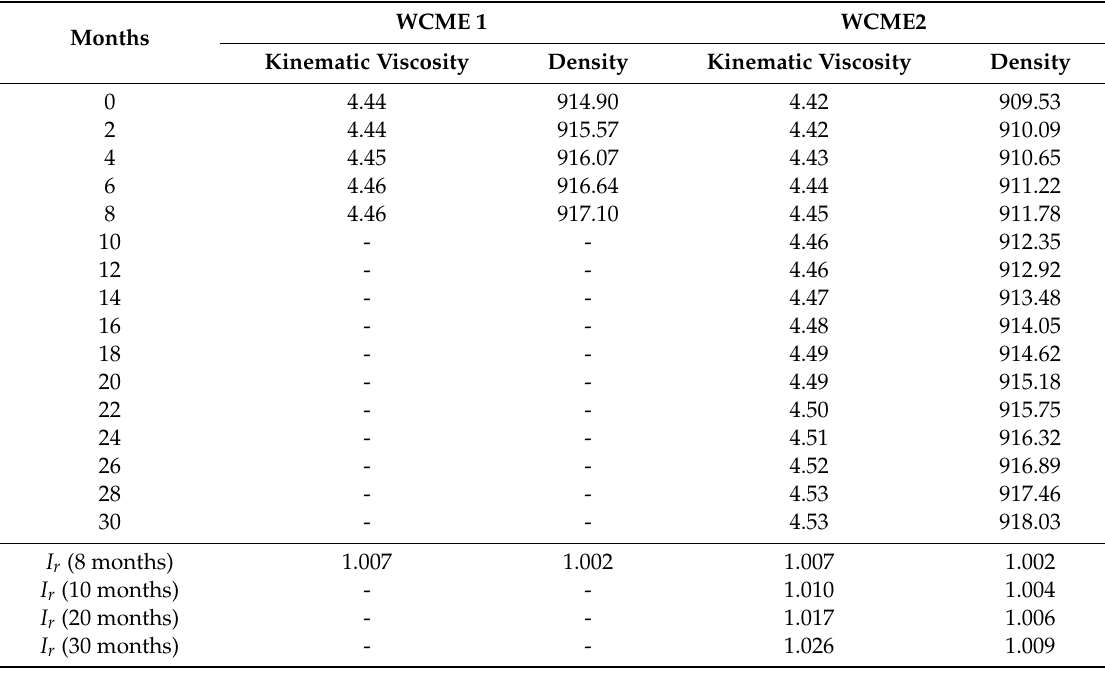
Table 4. Kinematic viscosity in mm 2 / s at 40 ◦ C and density in kg / m 3 at 15 ◦ C for WCME1 and